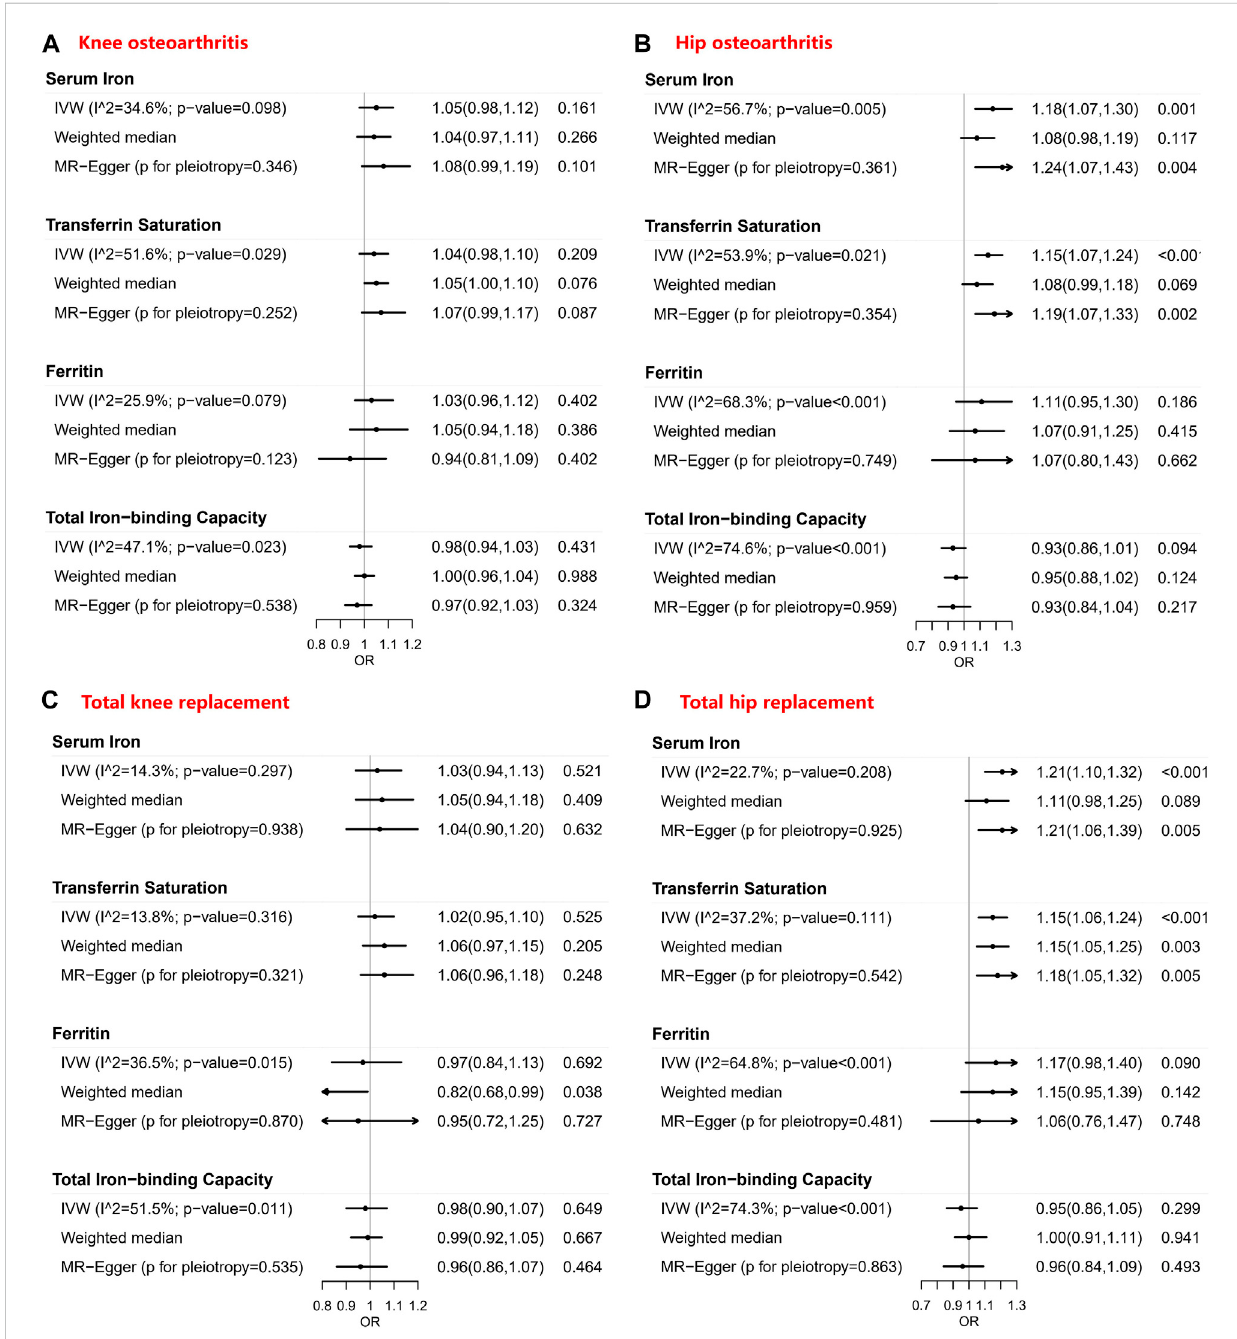
Forest plots of Mendelian randomization estimates for the association between genetically predicted systemic iron biomarkers with liberal instruments and knee osteoarthritis, hip osteoarthritis, total knee replacement, and total hip replacement. OR: Odds ratio; CI: Compatibility/con fi dence interval; IVW: Inverse-variance weighted. Points indicate the odds ratio per standard deviation increment increase in the iron biomarkers. Error bars indicate 95% compatibility/con fi dence intervals. (A) for knee osteoarthritis, (B) for hip osteoarthritis, (C) for total knee replacement, and (D) for total hip